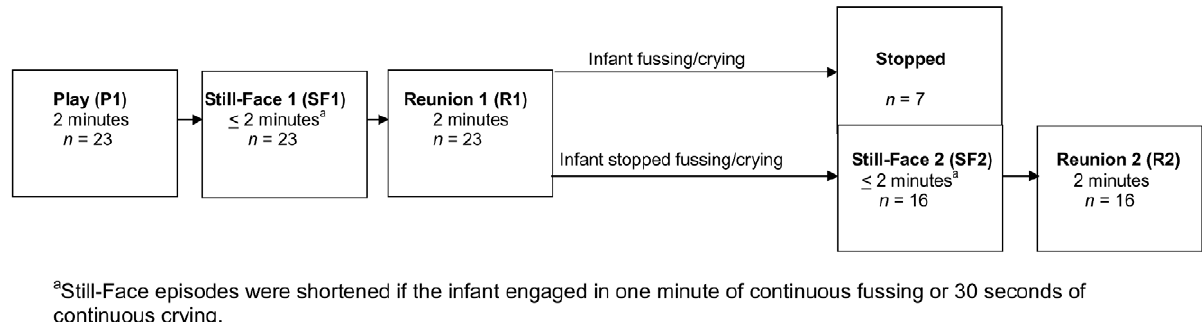
Figure 1. Overview of the Still-Face Paradigm.